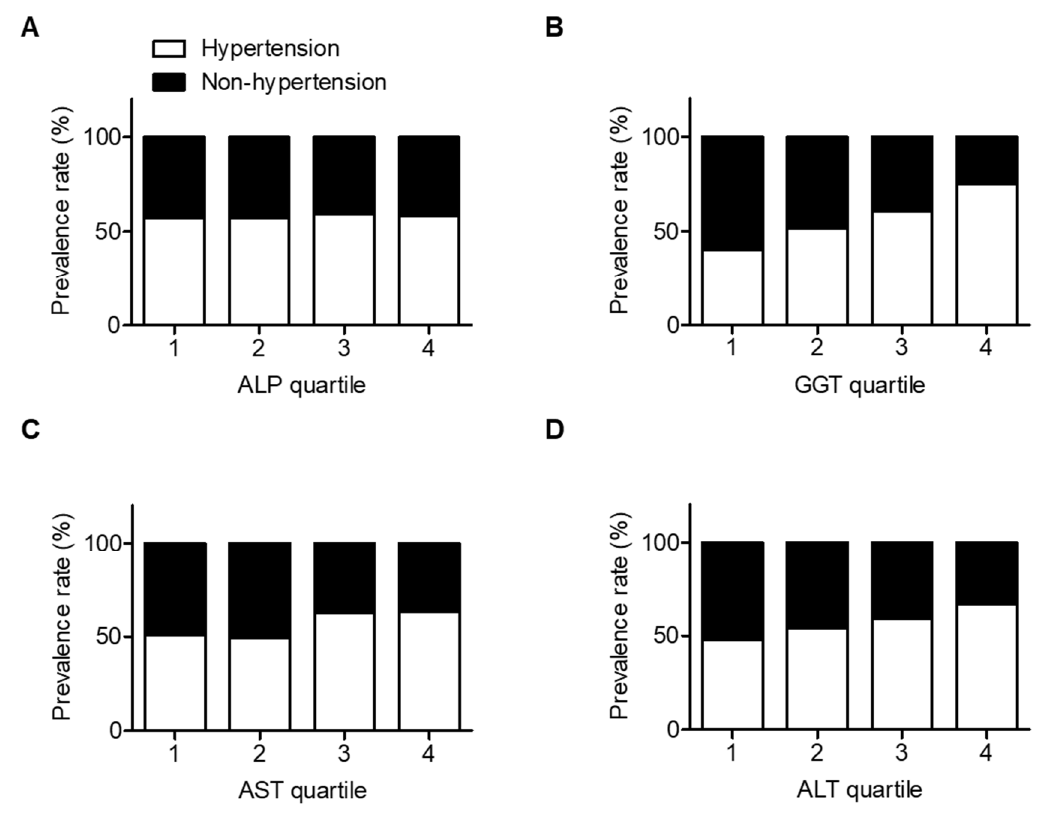
Figure 3. Prevalence of hypertension rate (%) according to liver enzymes quartile. ( A ) ALP, p for trend = 0.846; ( B ) GGT, p for trend < 0.001; ( C ) AST, p for trend = 0.018; and ( D ) ALT, p for trend = 0.004. Data are presented as N (%), Analyzed by Cochran–Armitage trend analysis. Abbreviation: ALP, alkaline phosphatase; GGT, gamma-glutamyltransferase; AST, aspartate aminotransferase; ALT, alanine aminotransferase.